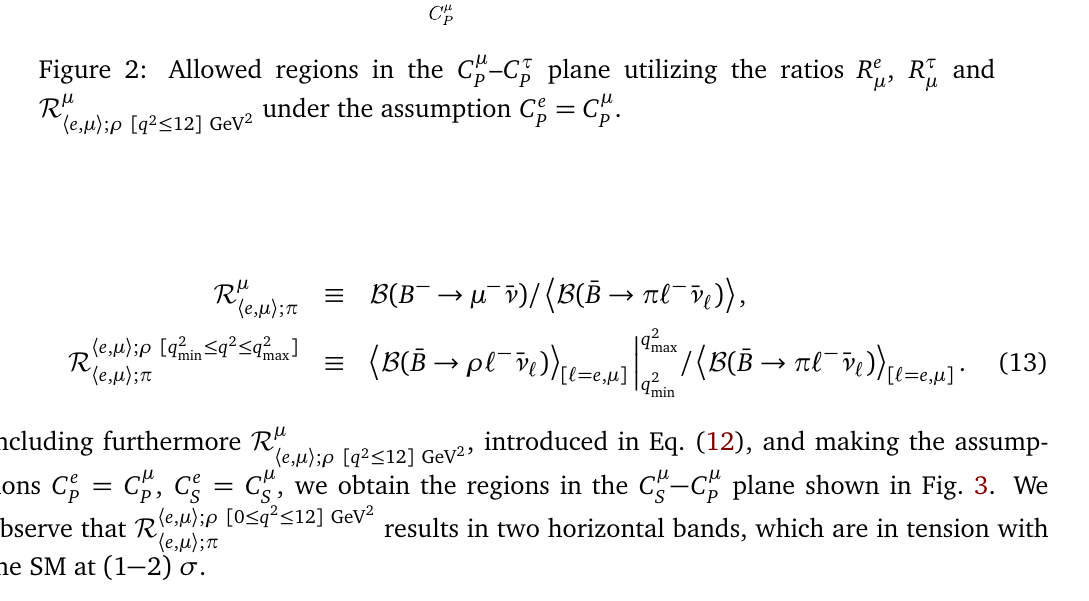
Figure 2: Allowed regions in the C